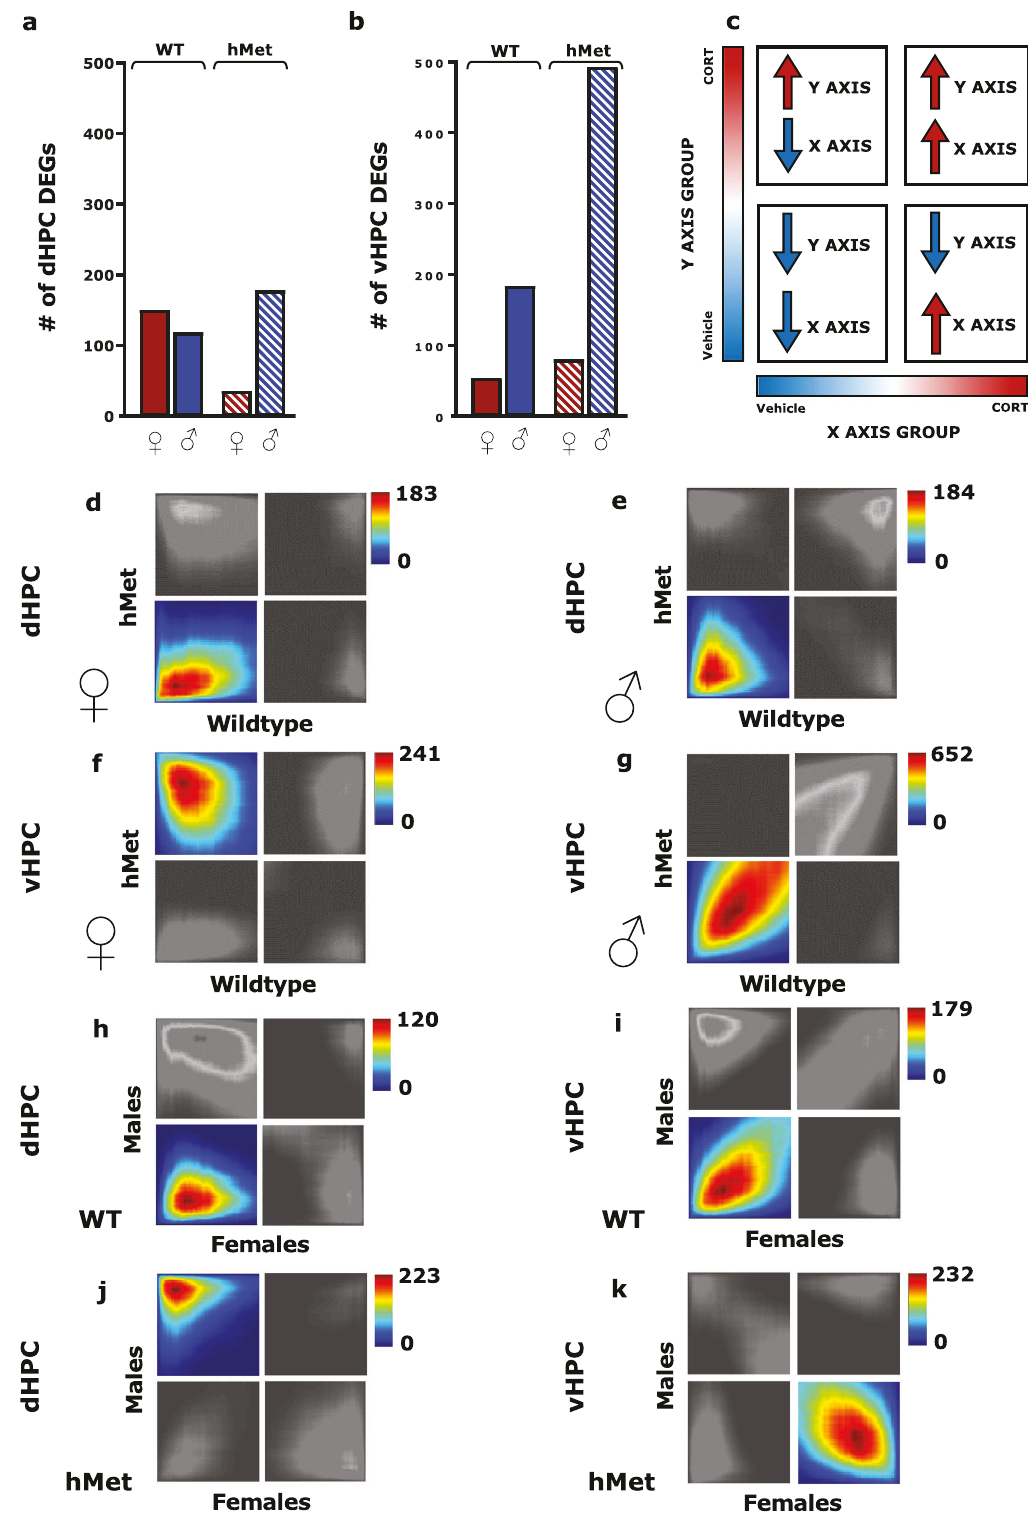
of sex and genotype. We then focused the investigation of sex differences in the vHPC by measuring the expression of the GR (encoded by Nr3c1 ) and its epigenetic regulation. Total Nr3c1 mRNA was reduced in WT females under CORT (64%; p < 0.0001), as well as hMet females ( p < 0.0001), but not in WT males or